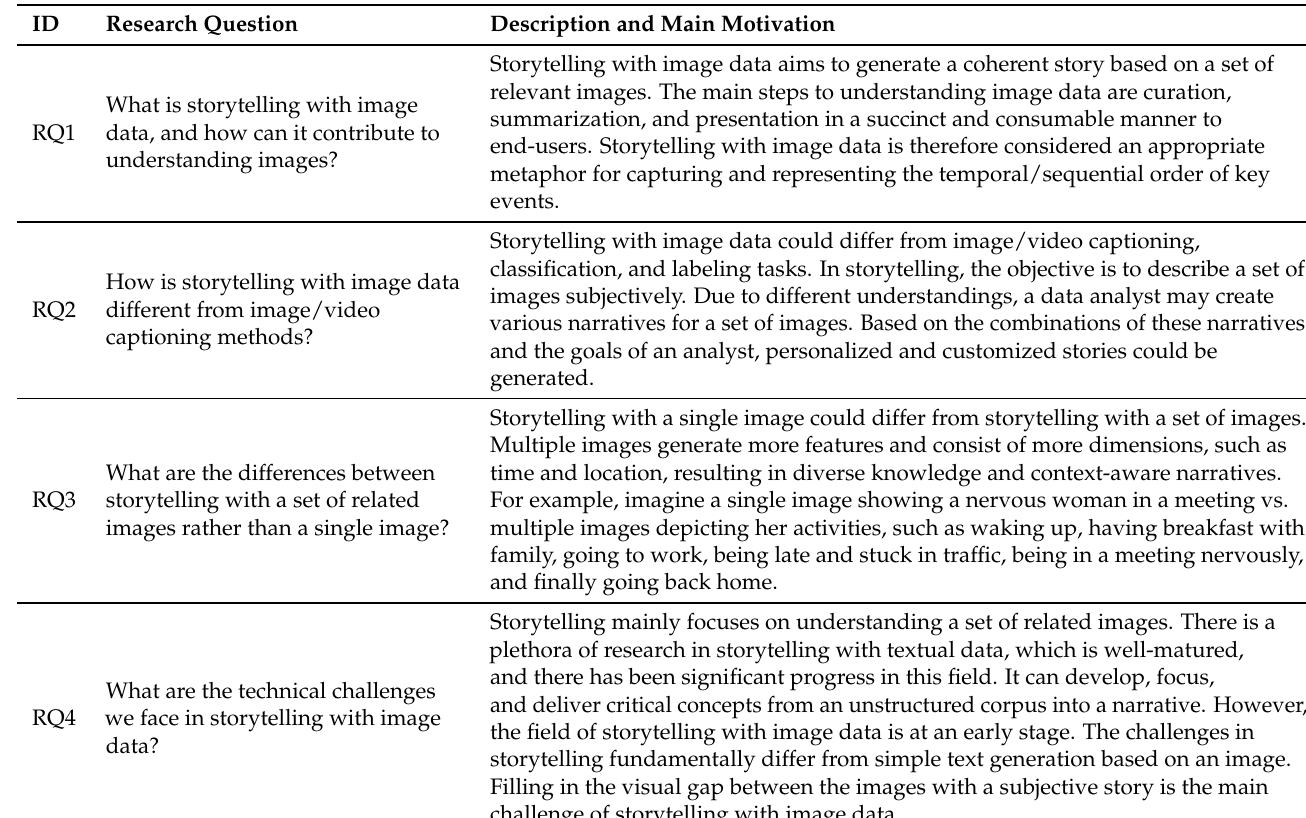
Table 1. Research questions (RQs) examined in this